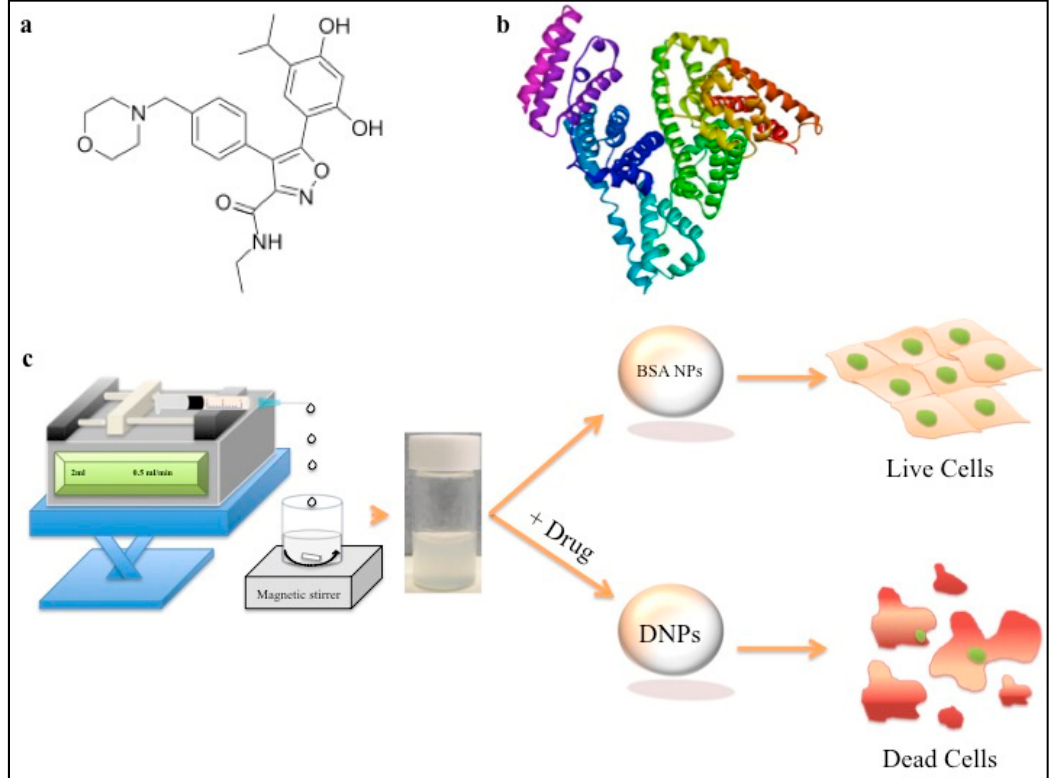
Figure 1. ( a ) and ( b ) Structure of luminespib and bovine serum albumin (BSA) (protein databank Figure 1. ( a , b ) Structure of luminespib and bovine serum albumin (BSA) (protein databank (PDB): (PDB): 3V03), respectively; ( c ) schematics of synthesis and anticancer efficacy of drug-loaded BSA 3V03), respectively; ( c ) schematics of synthesis and anticancer e ffi cacy of drug-loaded BSA nanoparticles nanoparticles (NPs) towards cancer cell lines in comparison to native or blank BSA NPs. (NPs) towards cancer cell lines in comparison to native or blank BSA Table 1. Physical-chemical characterization of drug-loaded BSA NPs (DNPs).